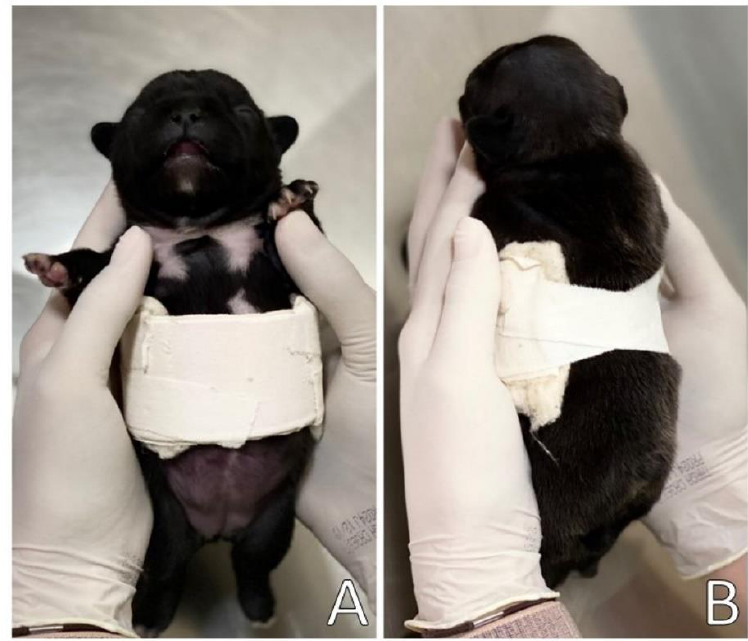
Figure 6. ( A ) Ventral view of the splint in the patient; ( B ) Dorsal view of the splint in the patient. The puppy remained hospitalized for eight hours. After placing the splint, the patient was released home, as he already presented improvement of the respiratory pattern (clinical evaluation). After 24 h, the newborn already had a sucking reflex and fed normally on the mother. During treatment, the use of the splint did not hinder breastfeeding (Figure 7).